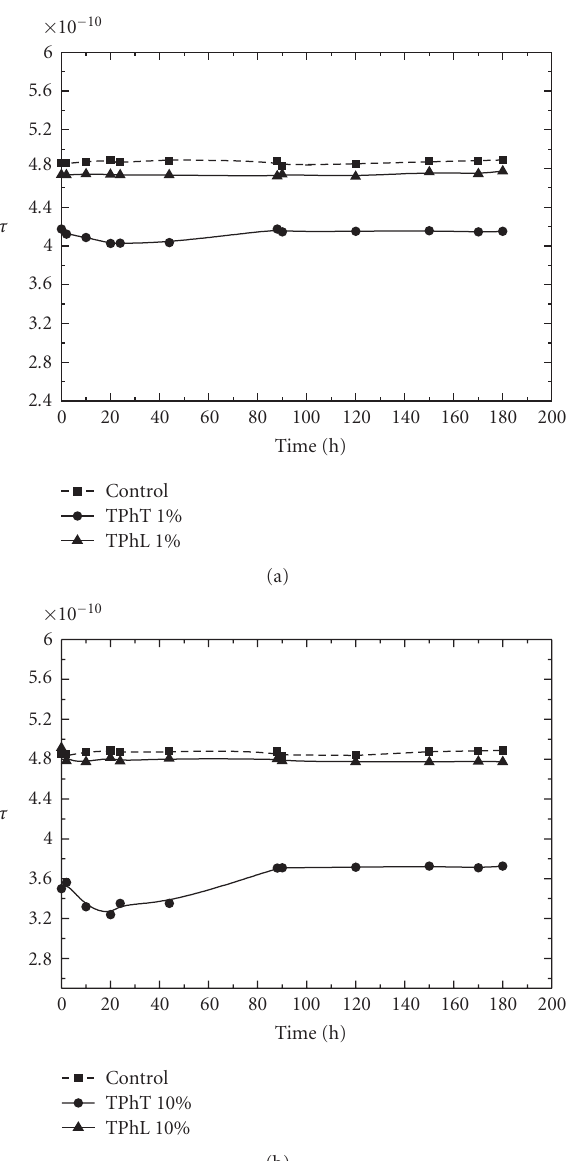
Figure 4: Time dependence of the value of the spectroscopic parameter τ (rotation correlation time) of the 16-DOXYL-stearic acid methyl ester probe, dissolved in the EYL liposome membranes containing admixtures of (a) 1% TPhT and TPhL; (b) 10% TPhT and TPhL. The dashed line on the diagrams marks the value of parameter τ for the control sample containing liposomes without a